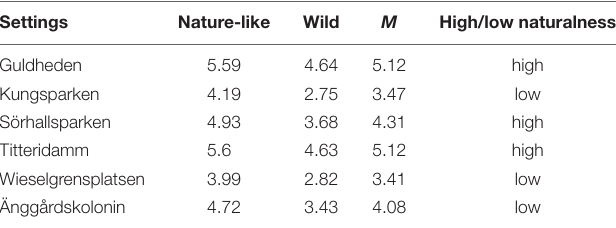
TABLE 1 | Mean estimations of the perceptual categories of nature-like and wild for the six settings, respectively, defining the two categories of high vs. low